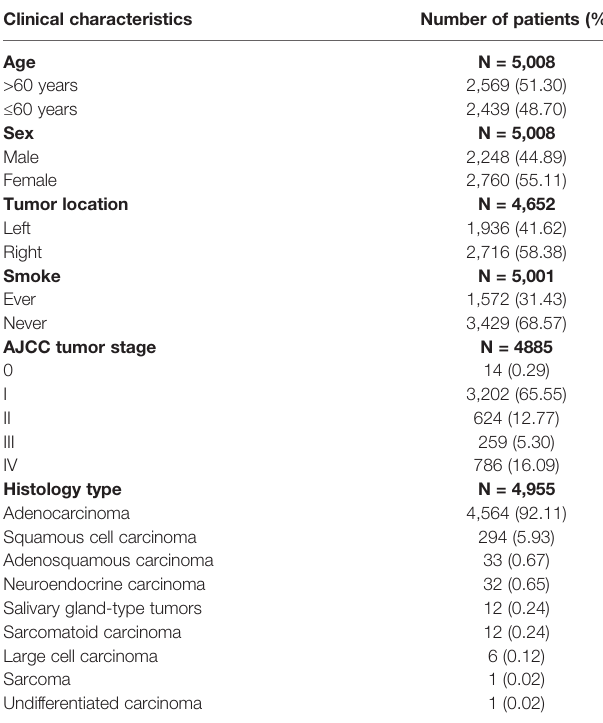
TABLE 1 | Basic clinical information of 5,008 cases of patients with lung